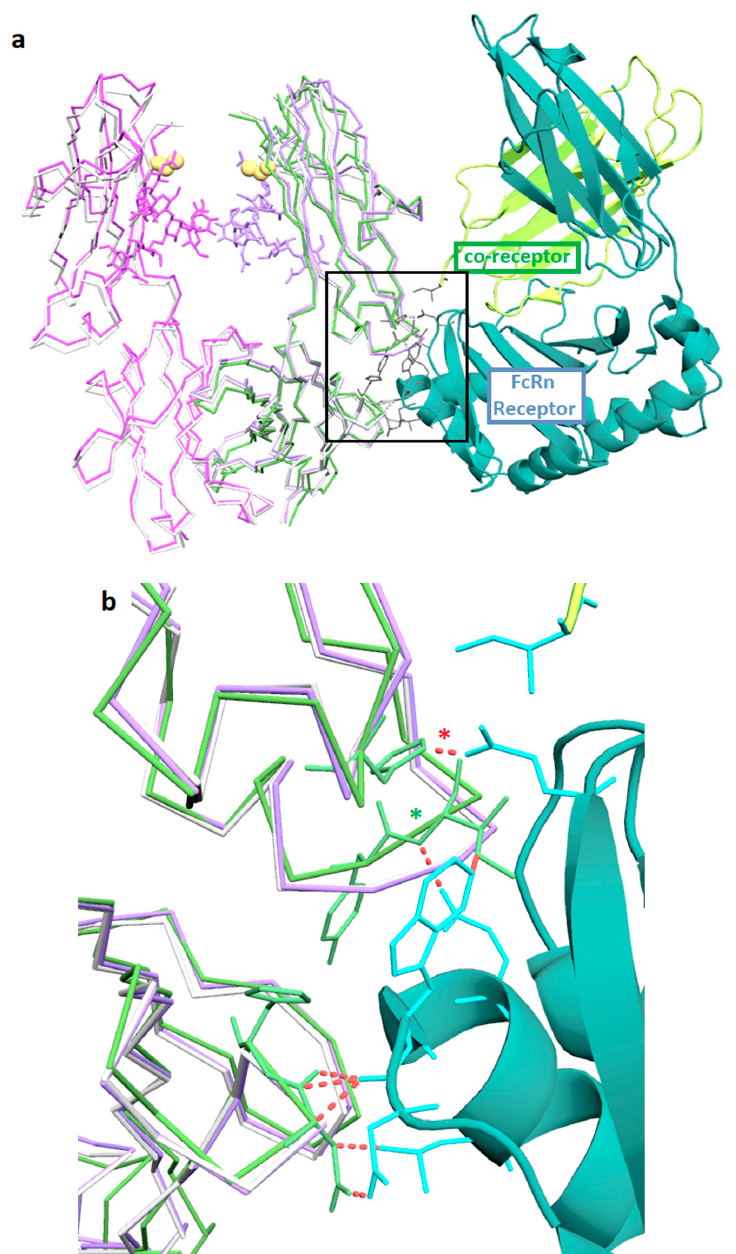
Figure 4. FcRn binding interface. ( a ) Superposition of Fc-C239i (A and B-chain in magenta and purple, with sticks for glycans) onto the complex (PDB: 4n0u) of Fc-wt (wild-type) (green) with the FcRn receptor (cyan and yellow cartoon). Yellow spheres show the location of the inserted cysteine in each chain. Also superposed is the uncomplexed wild-type (5VGP) in light gray. Gray sticks show key sidechains in the receptor interface, which is over 3.0 nm from the insertion. ( b ) Close up of the interface (box in ( a )). The pH dependence of binding is due to the histidine-containing ionic interaction indicated by the red asterisk. The green asterisk shows where a central interface loop is apparently bent upward by about 0.1 nm in the complex. The interface region appears structurally unaffected by the insertion (purple overlays closely with gray), consistent with biophysical measurements showing that FcRn binding is maintained.